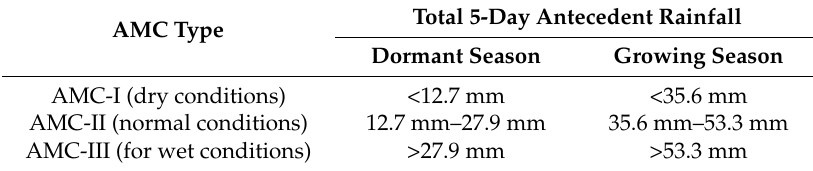
Table 3. Antecedent rainfall limits for determining AMC type [17].